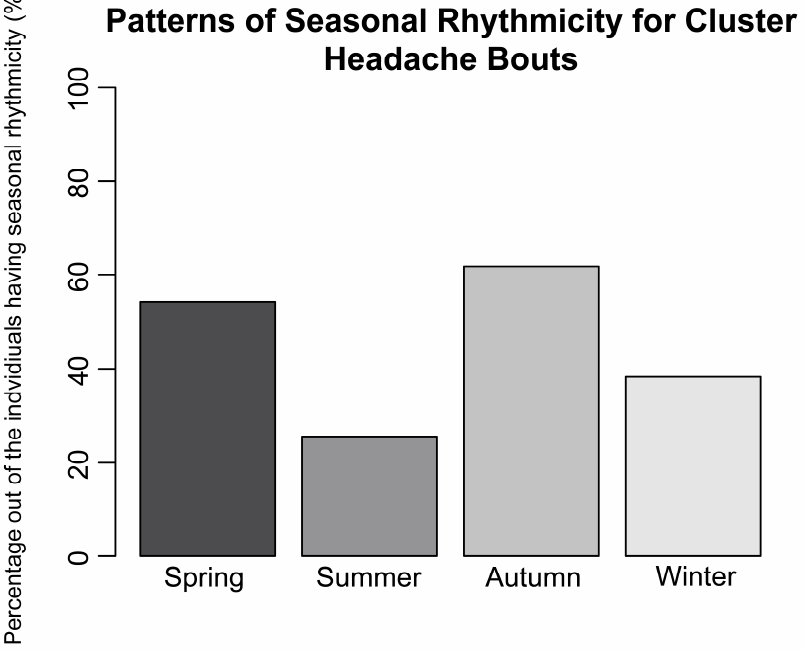
Figure 1. Patterns of seasonal rhythmicity for CH bouts, showing CH individuals who answered questions on seasonal rhythmicity in regard to their CH bouts (total— n = 301; those who answered yes— n = 149 (49.5%)). Percentages are based on CH individuals who experienced seasonal rhythmicity. CH = cluster headache. Patients were allowed to check more than one alternative.